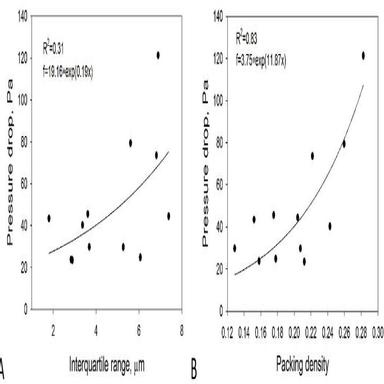
Effects of IQR of fibre diameter (A) and packing density (B) on pressure drop.